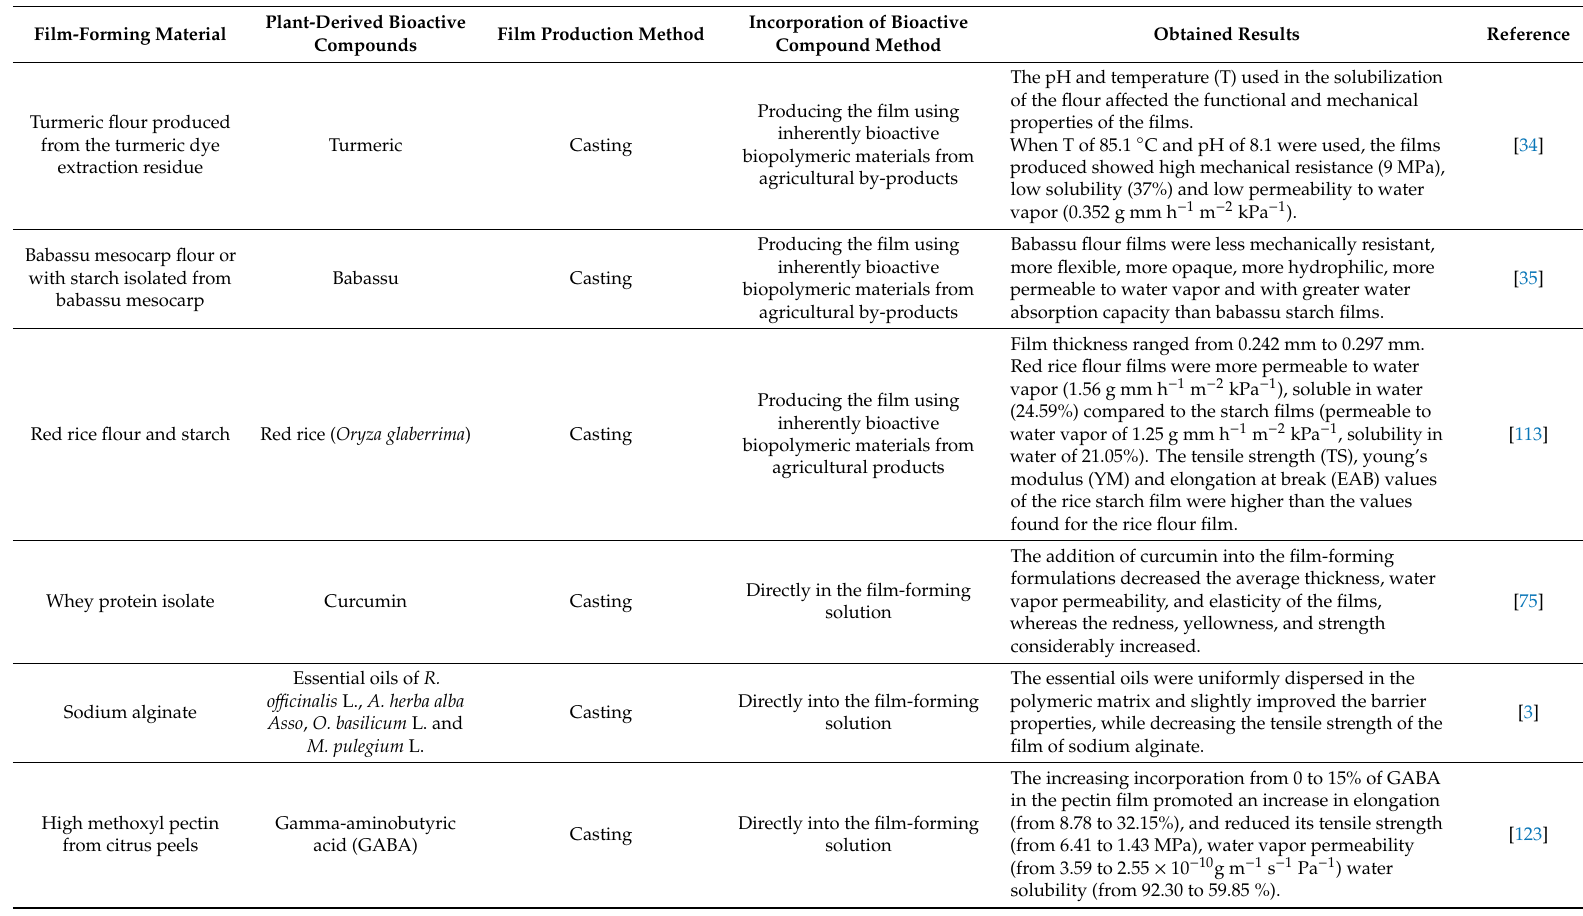
Table 3. Recent publications on the e ff ect of incorporating plant-derived bioactive compounds on the mechanical, barrier and physical properties of agro-based polymers